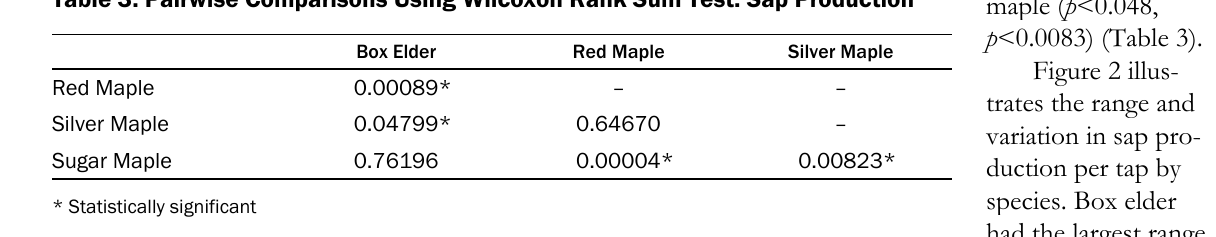
Table 3. Pairwise Comparisons Using Wilcoxon Rank Sum Test: Sap